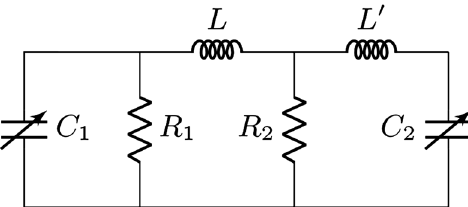
FIG. 7. A possible extension of the overdamped circuit of Fig. 3, where an additional inductance L 0 was introduced. In contrast to the circuit of Fig. 3, this circuit can be canonically